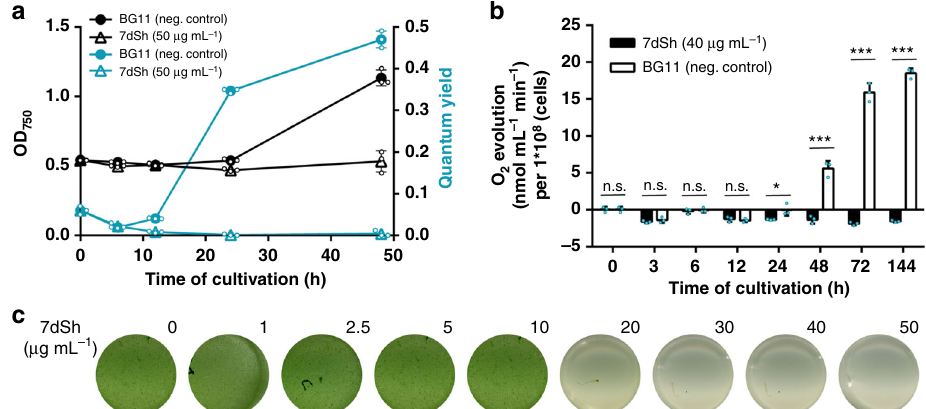
Fig. 4 7dSh ( 1 ) prevents regeneration of resuscitating Synechocystis . a Optical density (black) and PSII quantum yield (turquoise) of chlorotic Synechocystis cultures (initial OD 750 = 0.5) regenerating in the absence or presence of 7dSh. NaNO 3 (17.3 mM) and 7dSh (ca. 260 µ M) were added in aqueous solution at 0 h. Values represent the mean values of three biological replicates; standard deviations are indicated. Dots indicate data distribution. b Oxygen evolution of resuscitating Synechocystis cultures (initial OD 750 = 0.5) upon addition of nitrate (NaNO 3 , 17.3 mM) in the presence or absence of 7dSh (ca. 206 µ M). Signi fi cant differences between 7dSh treatment and untreated control for each timepoint were analyzed in an unpaired t -test (* p -value < 0.05; ** p -value < 0.01; *** p -value < 0.001; n.s., not signi fi cant). Values represent the mean values of three biological replicates; standard deviations are indicated. Dots indicate data distribution. c Cultures of chlorotic Synechocystis (initial OD 750 = 0.5) 48 h after addition of nitrate (NaNO 3 , 17.3 mM) and 7dSh. Numbers indicate concentration ( µ g mL − 1 ) of 7dSh added to the culture. Source data are provided as a Source Data fi